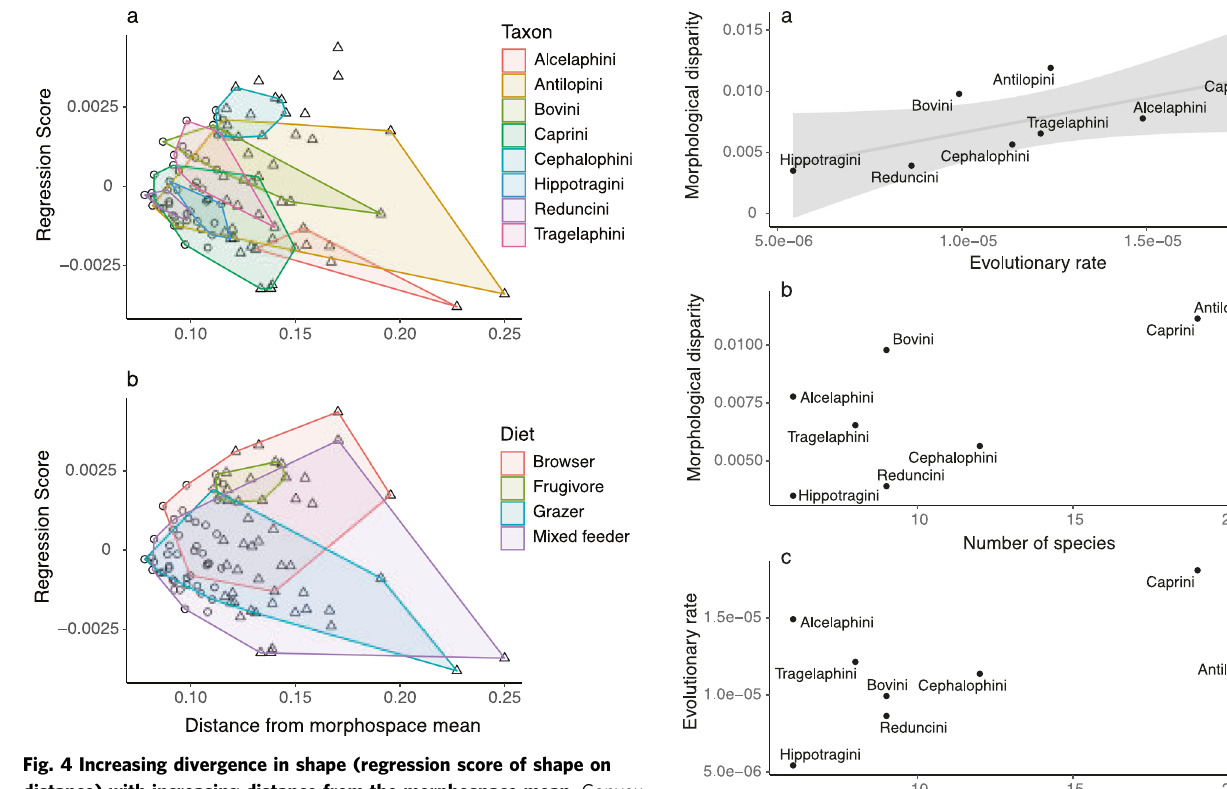
may play a role in the expansion of morphospace toward the peripheries (i.e., in increasing disparity).